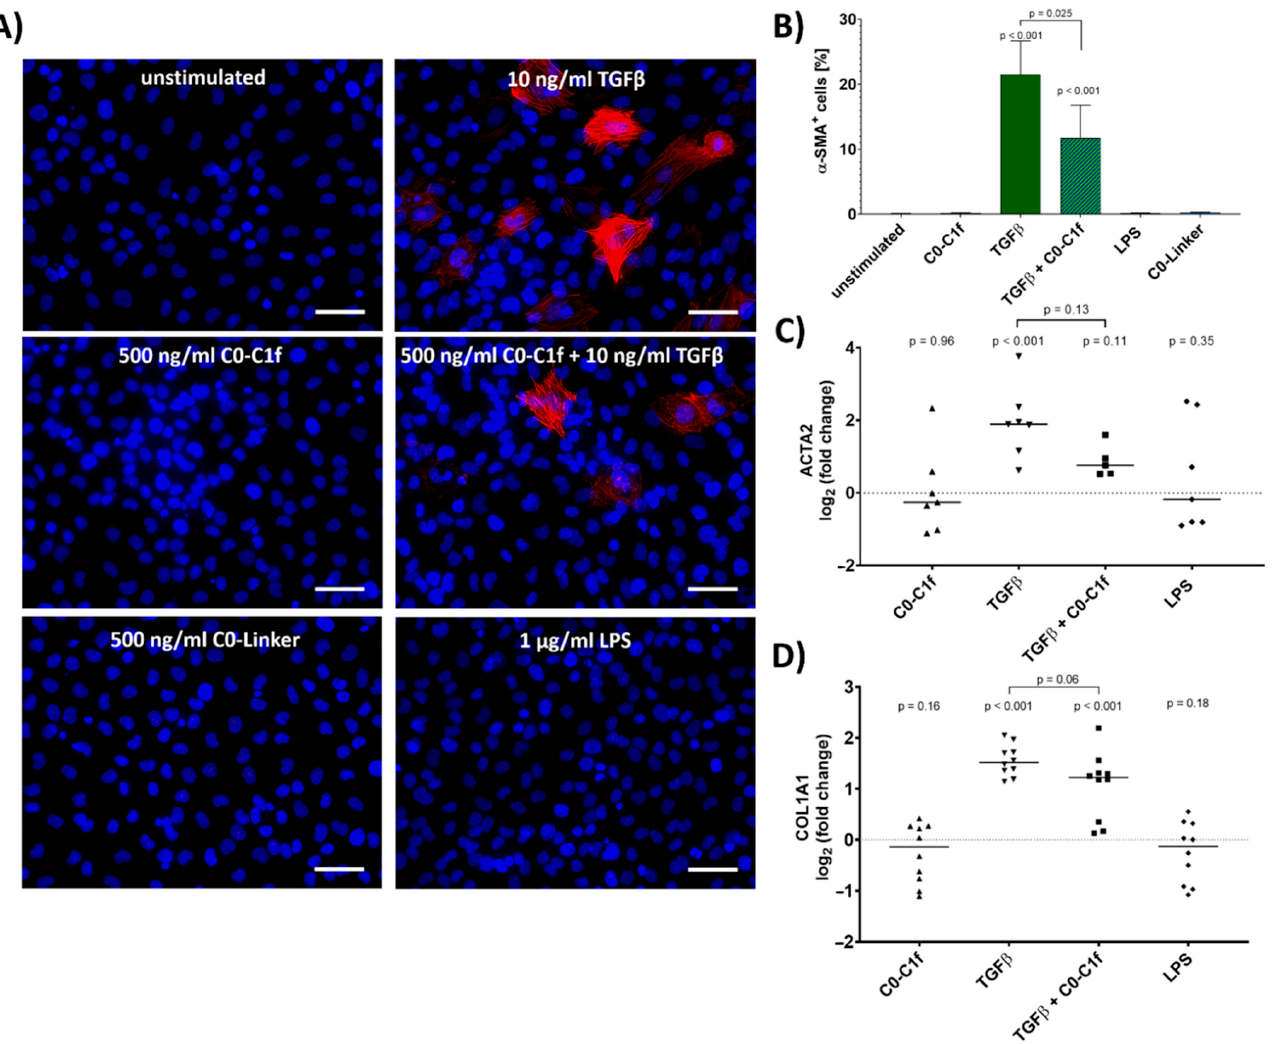
Figure 1. Conversion to myofibroblasts. huFib cells were treated with 10 ng/mL TGF β , 500 ng/mL C0-C1f, a combination of C0-C1f and TGF β , 500 ng/mL C0-Linker, or 1 µg/mL LPS. ( A ) Nuclei (blue) and α -SMA (red) were stained after 48 h of treatment under serum-free conditions. Scale bar = 50 µm ( B ) Quantification of α -SMA-positive cells, showing mean and SD (unstimulated n = 6, C0-C1f n = 3, TGF β n = 5, TGF β + C0-C1f n = 4, LPS n = 3, C0-Linker n = 3; n represents technical replicates). ( C , D ) Quantification of mRNA expression levels of ACTA2 and COL1A1 after 24 h treatment by qPCR. Data are displayed as individual data points and means; p -values above each condition refer to differences between means (horizontal lines) and 0 fold change (unstimulated controls) unless otherwise indicated. (ACTA2 n = 7, TGF β + C0-C1f n = 5; COL1A1 n = 10; n represents biological replicates).